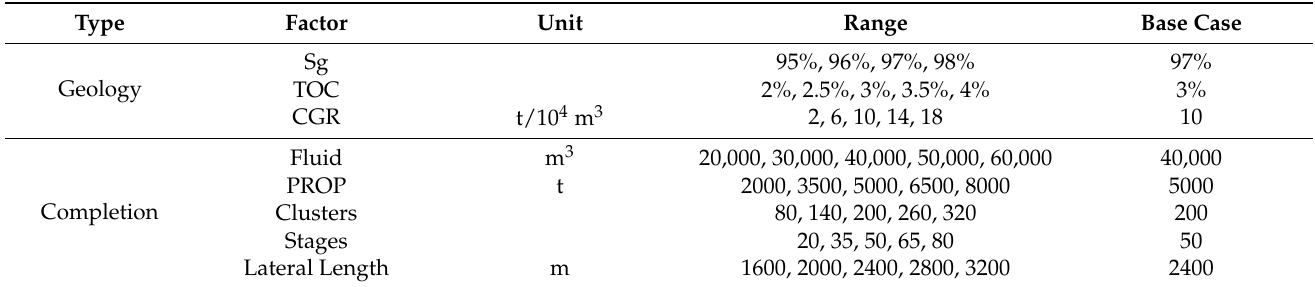
Figure 6. Tornado plot illustrating the most and the least important factors for M6GAS. Each red bar equals to a sensitivity measure (compared with a base example) when a factor is designed to its upper bound. The green bars indicate the lower-bound case. The blue line in the middle means the base case. Factors are arranged by descending order from top to bottom. Table 9. Summary of geological and engineering factors for sensitivity